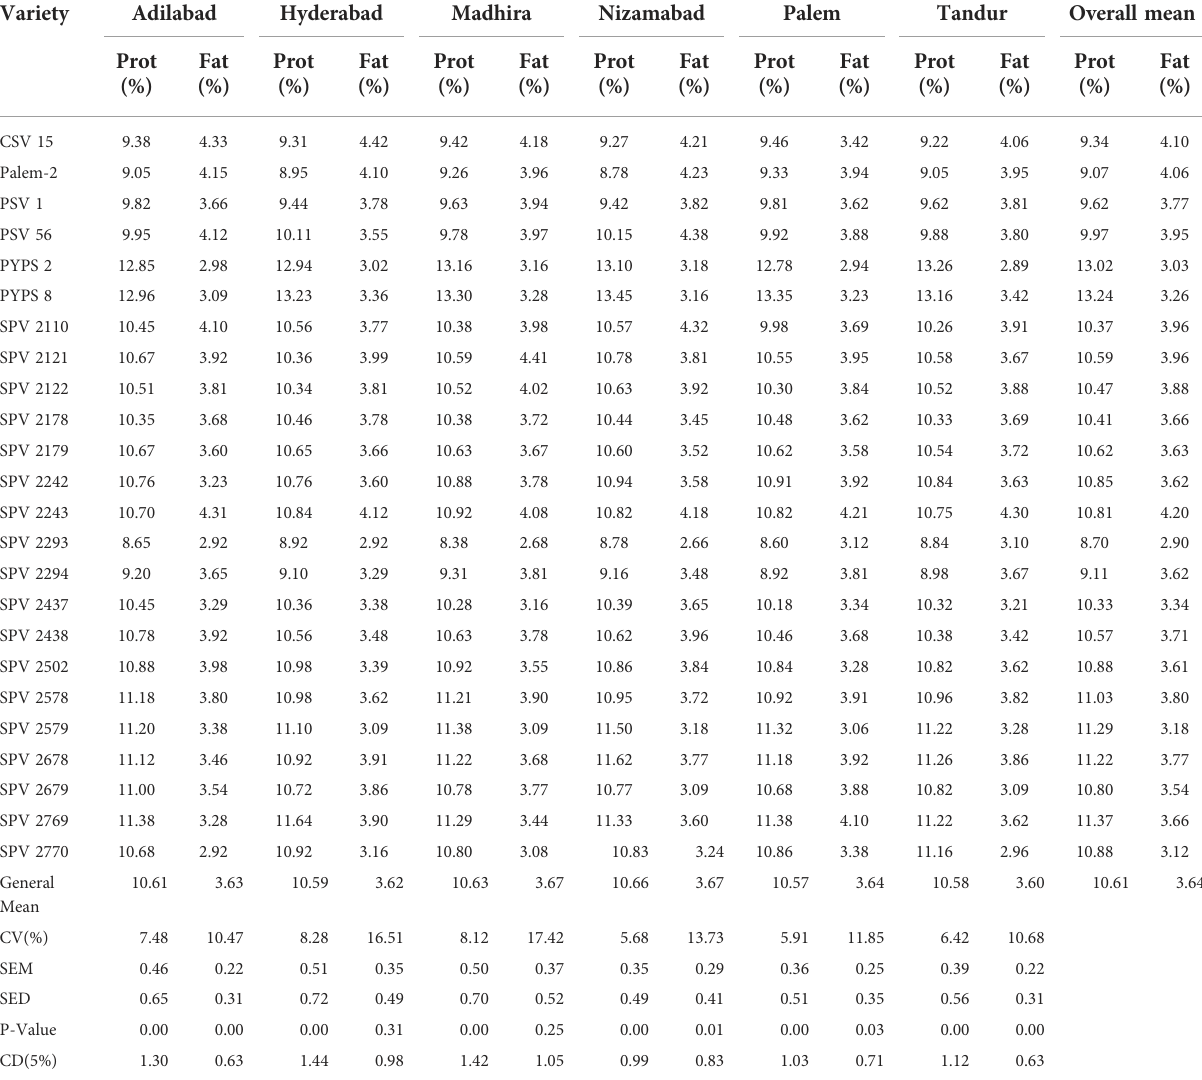
TABLE 5 Protein and fat contents in sorghum varieties evaluated at six locations during 2020-21.